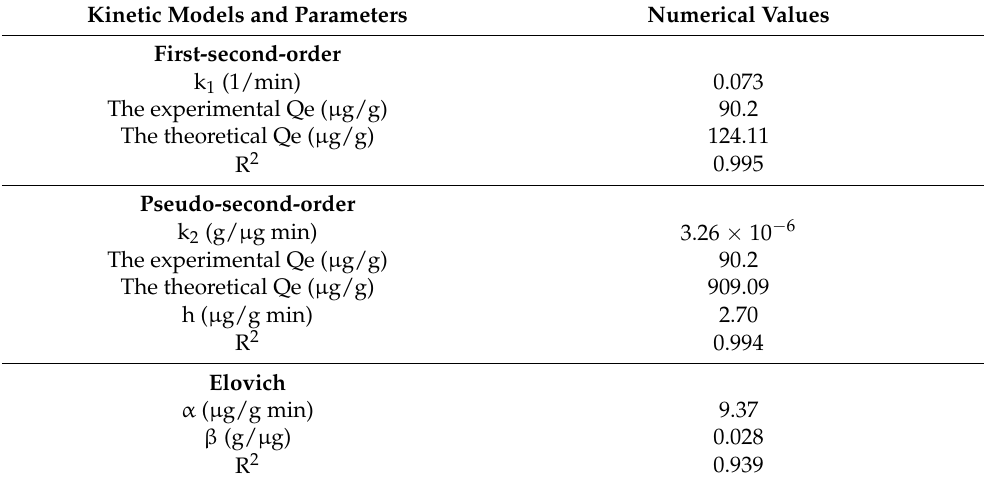
Table 2. Kinetic parameters of